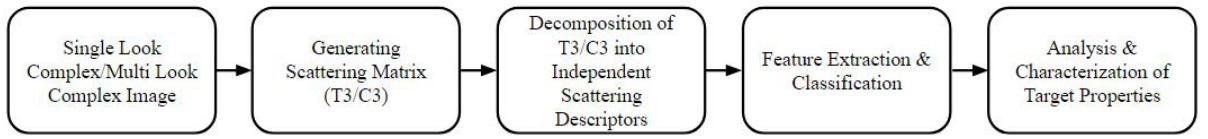
Figure 1. Flow of Multi-Polarized SAR Image